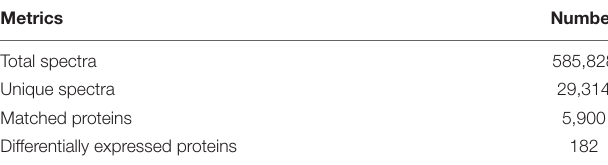
TABLE 3 | Summary of iTRAQ metrics from the Cry1Ah-resistant strain (ACB-AhR) and susceptible strain (ACB-BtS) of Ostrinia furnacalis proteomes.